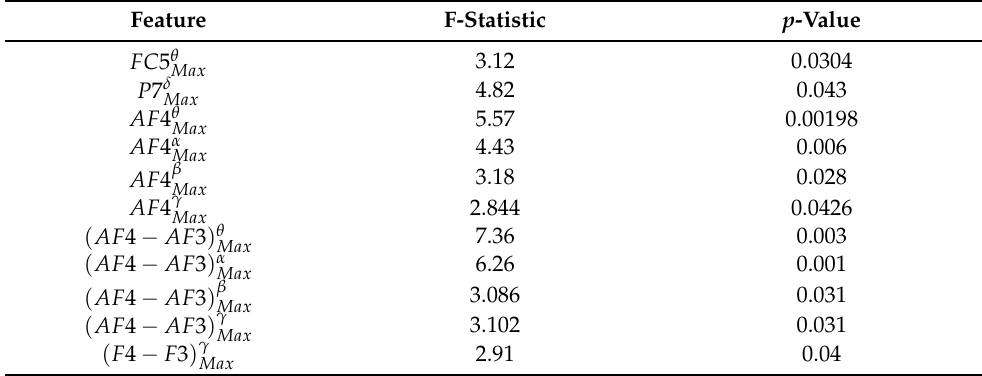
Table 10. Repeated ANOVA tests over selected EEG